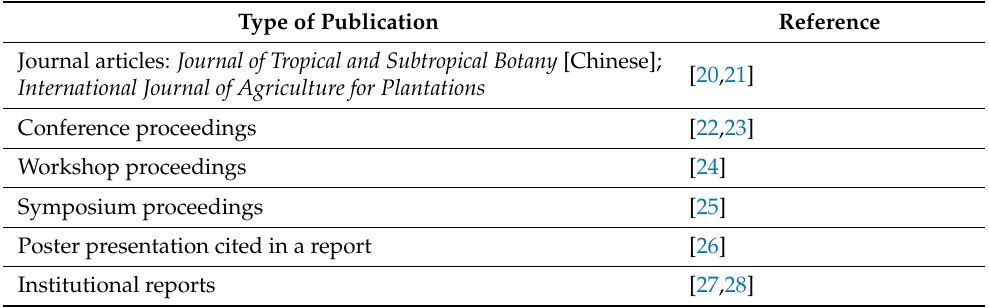
Table 7. Articles found with Google Scholar for “Dipterocarpaceae and Cryopreservation”.